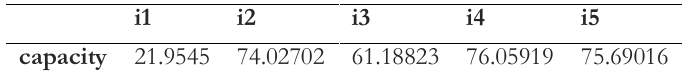
Table 8. Capacity of facility.